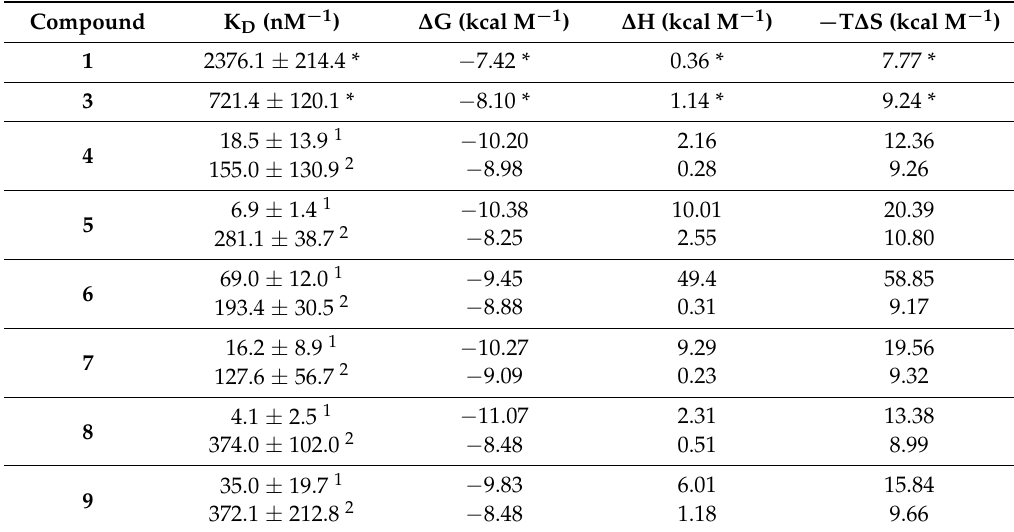
Table 2. Thermodynamic parameters from ITC analysis of compounds 1 , 3 – 9